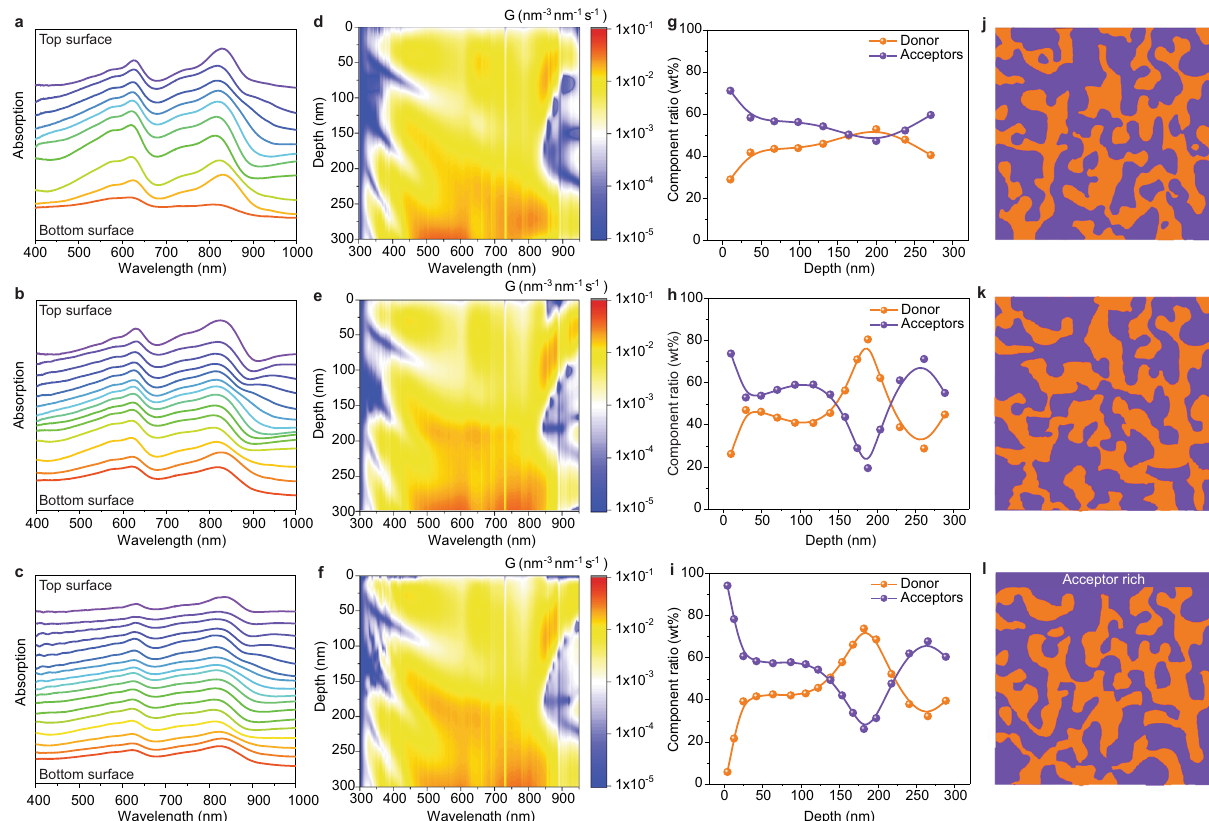
Fig. 3 Film-depth-dependent phase segregation and exciton generation contours. a – c Film-depth-dependent light absorption spectra of 300 nm-thick ( a ) PM6:L8-BO-F blend, b PM6:BTP-eC9:L8-BO-F blend, and ( c ) LBL-processed PM6:BTP-eC9:L8-BO-F blend. The spectra are vertically shifted for clarity, to show the optical properties at different fi lm-depth. d – f Exciton generation contours of 300 nm-thick ( d ) PM6:L8-BO-F blend, e PM6:BTP-eC9:L8-BO-F blend, and ( f ) LBL-processed PM6:BTP-eC9:L8-BO-F fi lm, as simulated from spectra of ( a – c ) in combination with optical transfer-matrix approach. The “ noise ” -like vertical lines are due to features of the AM 1.5G solar spectra. 0 nm and 300 nm represent active layer/PNDIT-F3N and PEDOT:PSS/active layer interfaces, respectively. The incident light is from the bottom side. g – i Film-depth-dependent composition pro fi les as extracted from ( a – c ). The scatters are from experimental measurements and the lines are guides to eyes. j – l Schematic illustration of the vertical phase separation of different